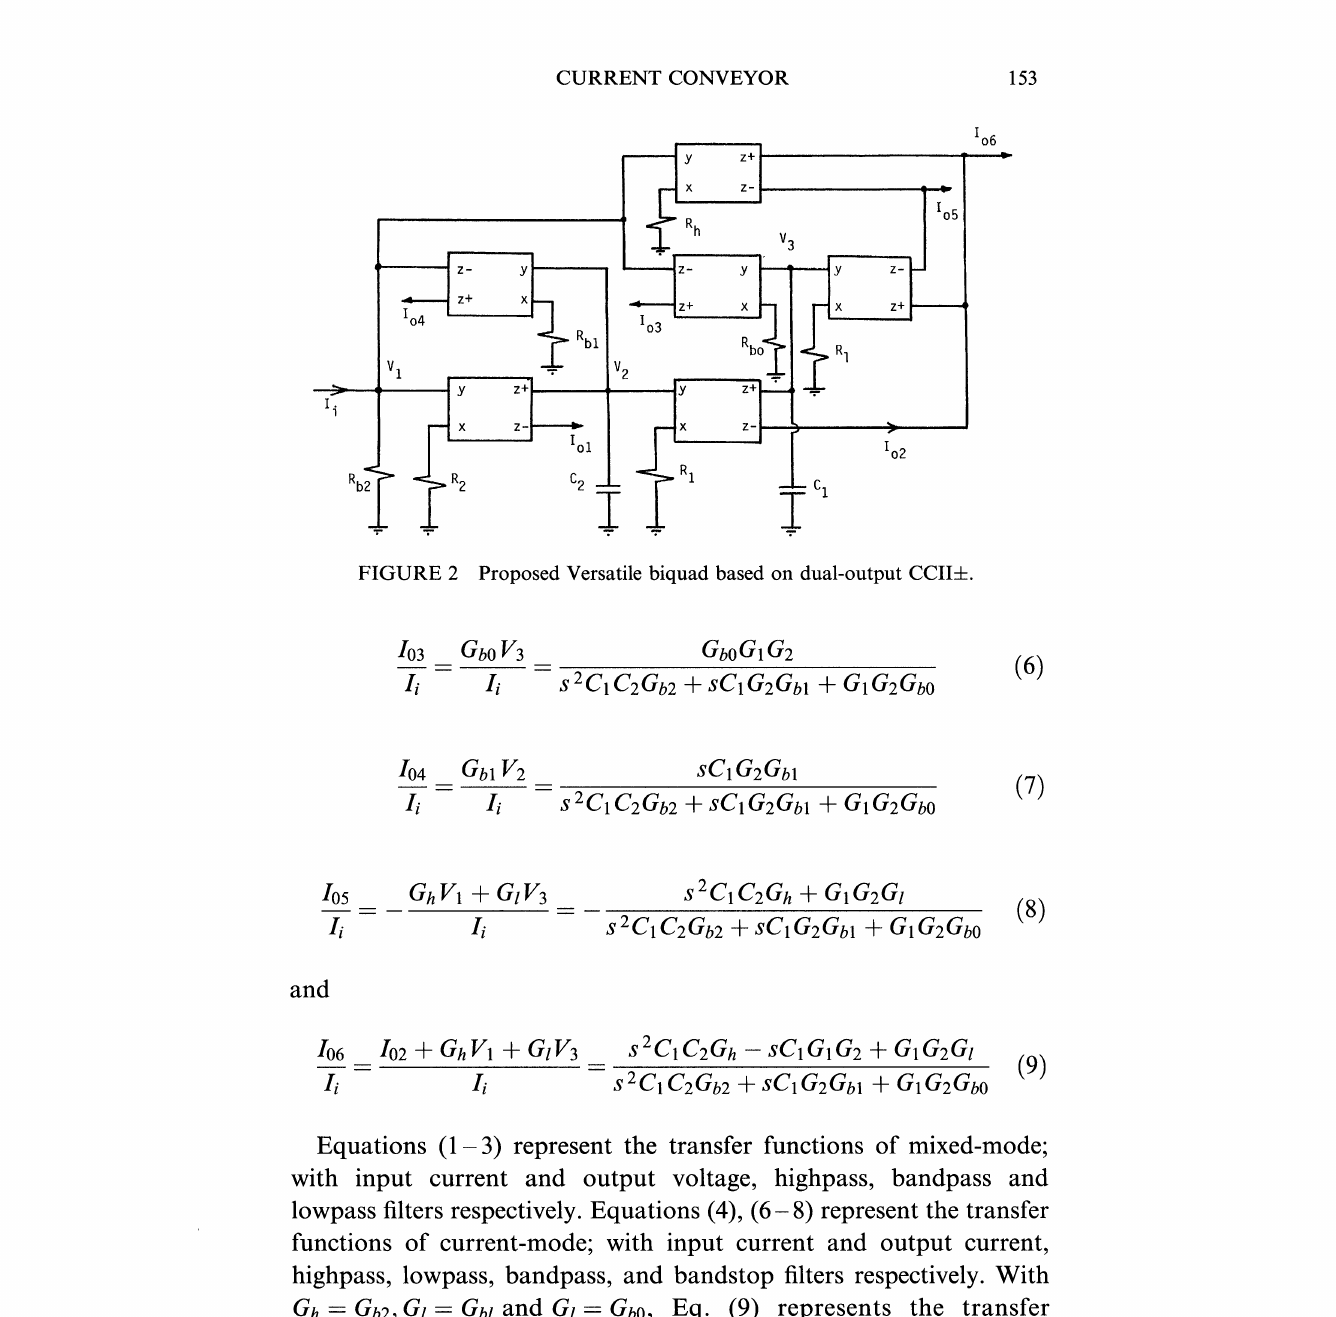
FIGURE 2 Proposed Versatile biquad based on dual-output